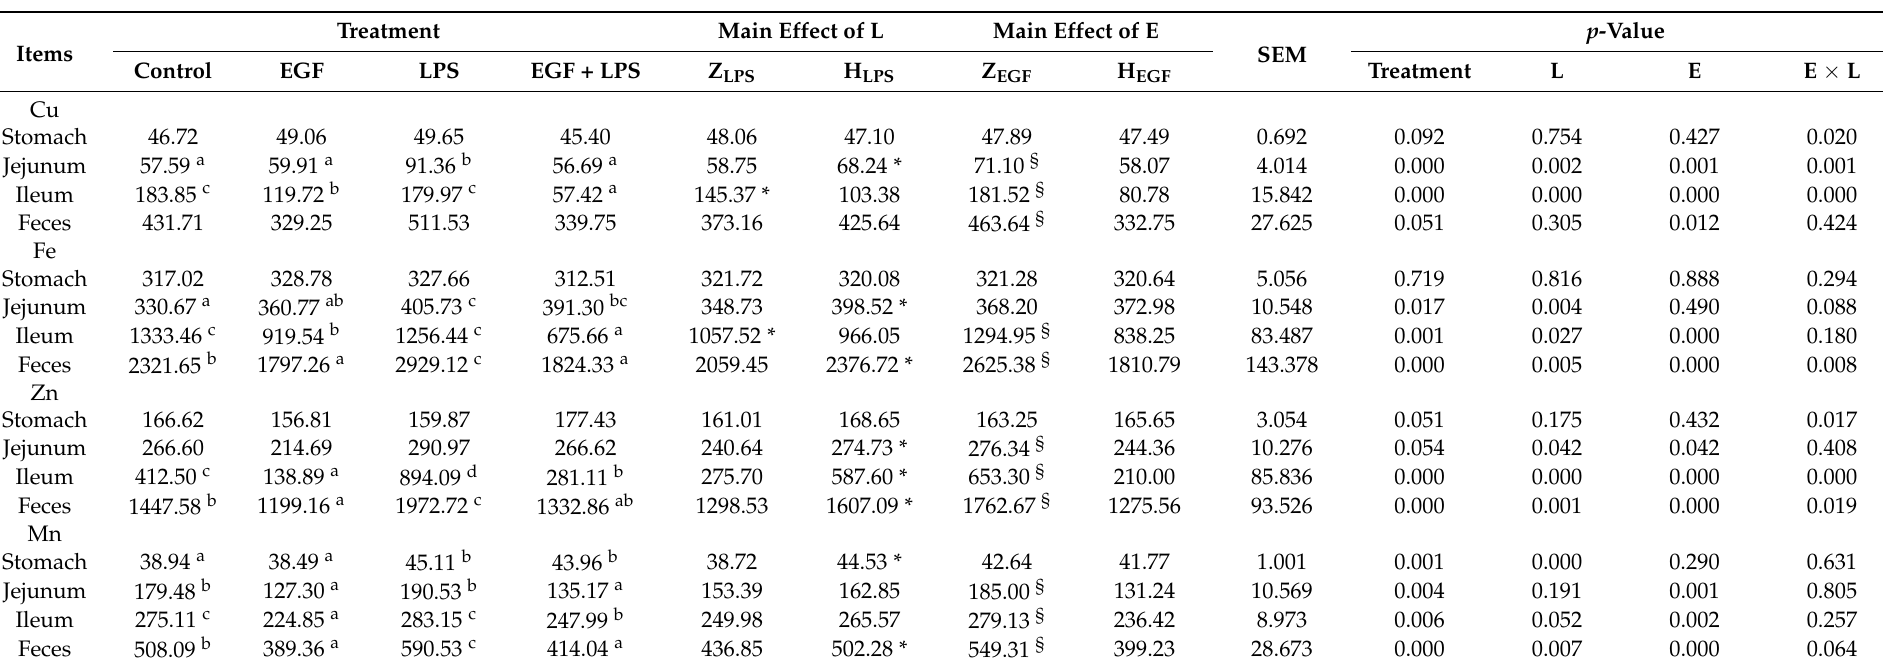
Table 5. EGF attenuates the effect of LPS on the concentration of Cu, Fe, Zn, Mn in the gastrointestinal tract chyme and feces of early-weaning piglets (dry matter,